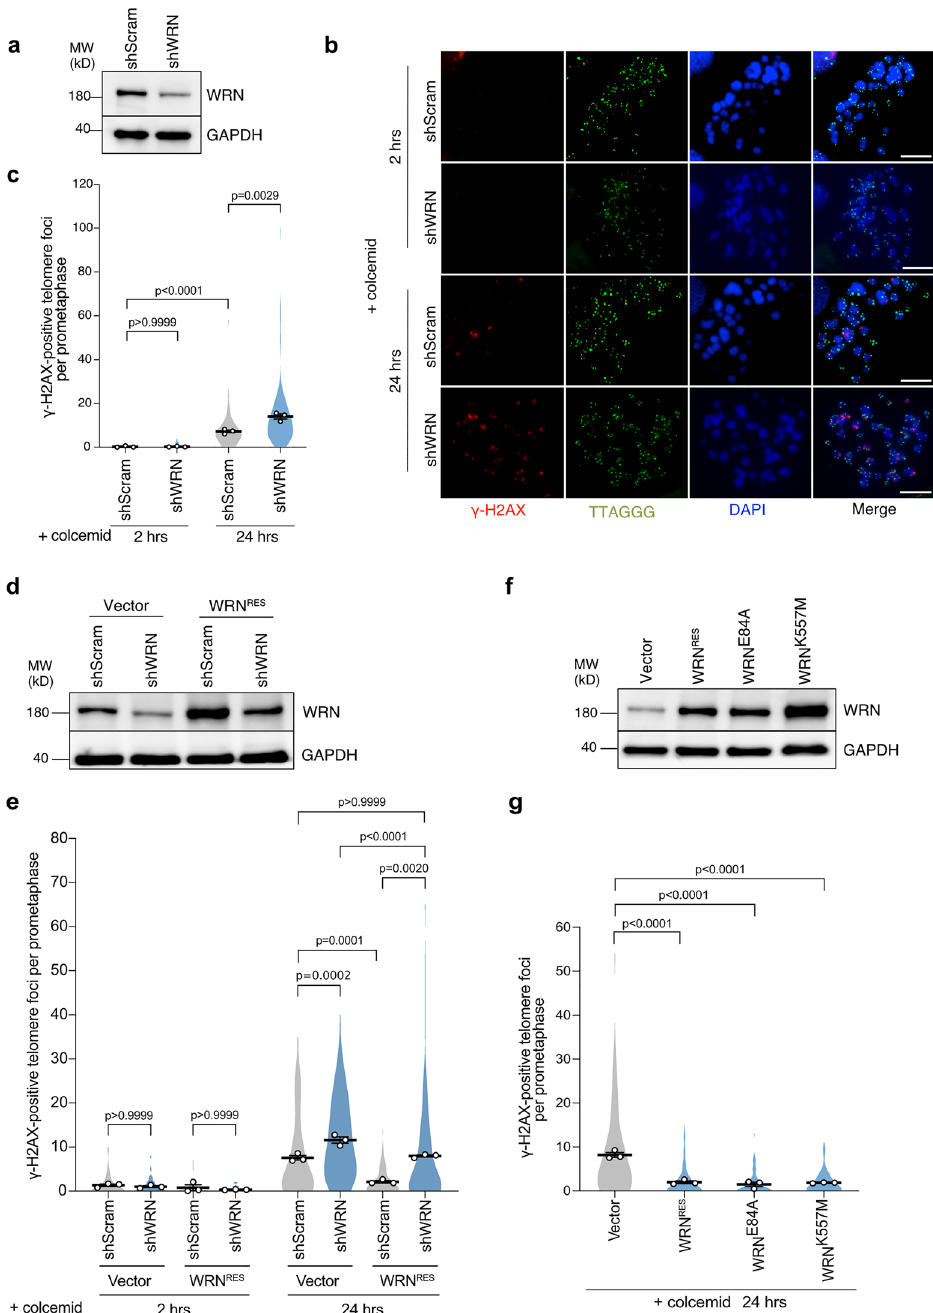
Figure 1. Mitotic telomere deprotection is suppressed by WRN helicase independently of its catalytic activities. ( a ) Immunoblot of WRN in IMR-90 E6E7 hTERT cells transduced with shWRN or shScramble for 5 days. GAPDH serves as a loading control. ( b ) Representative images of meta-TIF assay from WRN knockdown cells after treatment with 100 ng/ ml colcemid. The images show DAPI (blue), γ-H2AX (red), and telomere FISH (green). Scale bar, 10 µm. ( c ) Quantification of telomeric signals colocalized with γ-H2AX foci per chromosome spread in indicated conditions. Violin plots illustrate the distribution of all data and averages from three independent experiments (n = 15/experiment for 2 h colcemid; n = 30/ experiment for 24 h colcemid; mean ± s.e.m.; Kruskal–Wallis followed by Dunn’s test). ( d ) Immunoblot of WRN in IMR-90 E6E7 hTERT cells expressing exogenous WRN RES or Vector. Cells were transduced with shScramble or shWRN for 5 days before analysis. GAPDH serves as a loading control. ( e ) Quantification of telomeric signals colocalized with γ-H2AX foci in indicated conditions as shown in c (n = 15/experiment for 2 h colcemid; n = 30/experiment for 24 h colcemid; mean ± s.e.m.; Kruskal–Wallis followed by Dunn’s test). ( f ) Immunoblot of WRN in cells expressing WRN RES and indicated WRN mutants. Transduced cells were harvested on day 10 post-infection. GAPDH serves as a loading control. ( g ) Quantification of telomeric signals colocalized with γ-H2AX foci in indicated conditions as shown in c (n = 30/experiment; mean ± s.e.m.; Kruskal–Wallis followed by Dunn’s test). Unprocessed blot images are shown in Supplementary Information